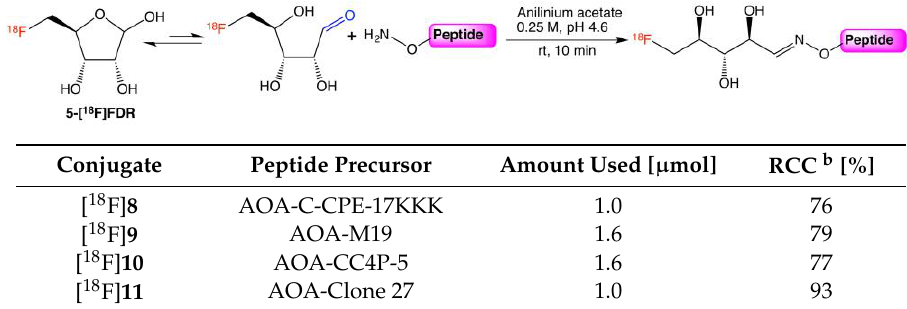
Table 3. Conjugation of 5-[ 18 F]FDR with aminooxy-functionalized peptides in anilinium acetate buffer a .